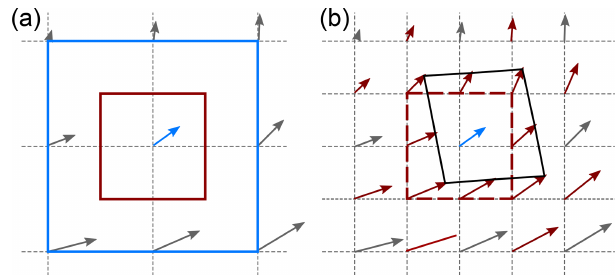
Figure 2. Multi-pass PIV with window deformation. (a) First pass (blue area) with 50% overlap generates the grey vectors as well as the blue vector in the centre; (b) second step with smaller interro- gation window (red area in panel a ). The results of the first pass are interpolated linearly, or using a spline function, onto the vector grid of the second pass. The interpolated vectors (red vectors) are employed to shift and deform the interrogation prior to correlation. The correlation is then employed to correct the interpolated